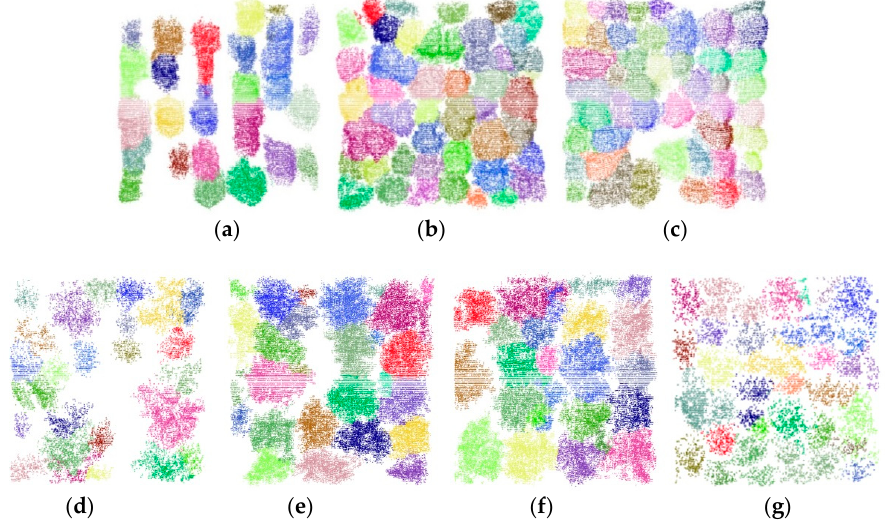
Figure 7. Results of the voxel-based mean shift method for seven plots: ( a ) Plot 1, ( b ) Plot 2, ( c ) Plot 3, ( d ) Plot 4, ( e ) Plot 5, ( f ) Plot 6, and ( g ) Plot 7.